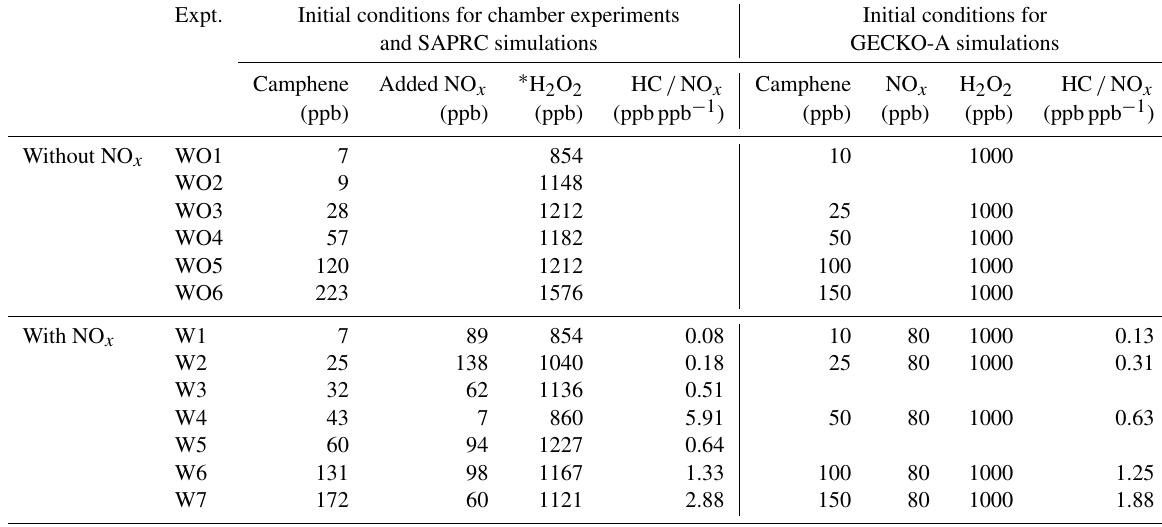
Table 1. Summary of initial conditions for chamber experiments and box model simulations. Expt. Initial conditions for chamber experiments Initial conditions for and SAPRC simulations GECKO-A simulations Camphene Added NO x HC / NO x